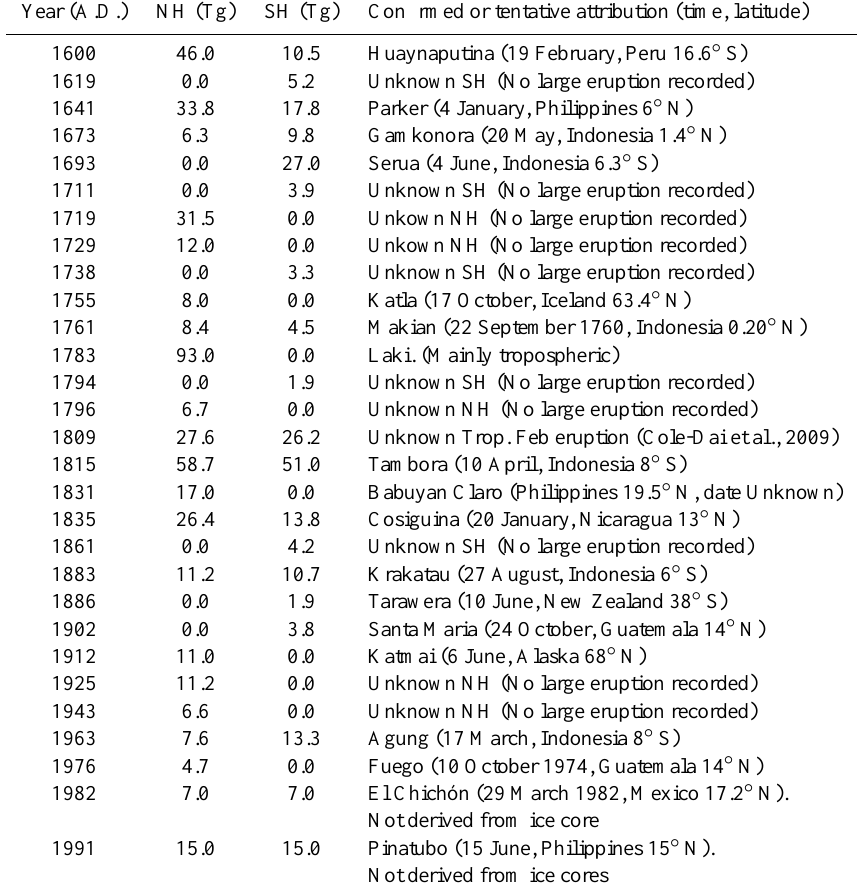
Table 1. Stratospheric aerosol data after ice core calibrations for Northern and Southern Hemispheres from Gao et al. (2008). Attribution of the aerosol peaks to specific volcanic eruptions in this study. Tg amounts correspond to the total aerosol mass (H 2 SO 4 +H 2 O) assuming a 75wt% of H 2 SO 4